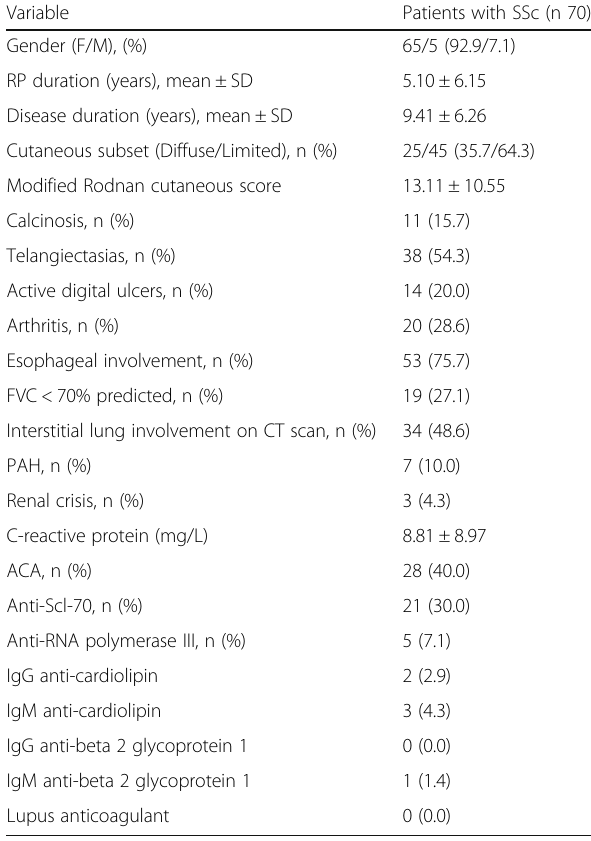
Table 1 Demographic and clinical features of the SSc patients Variable Patients with SSc (n 70) Gender (F/M), (%) 65/5